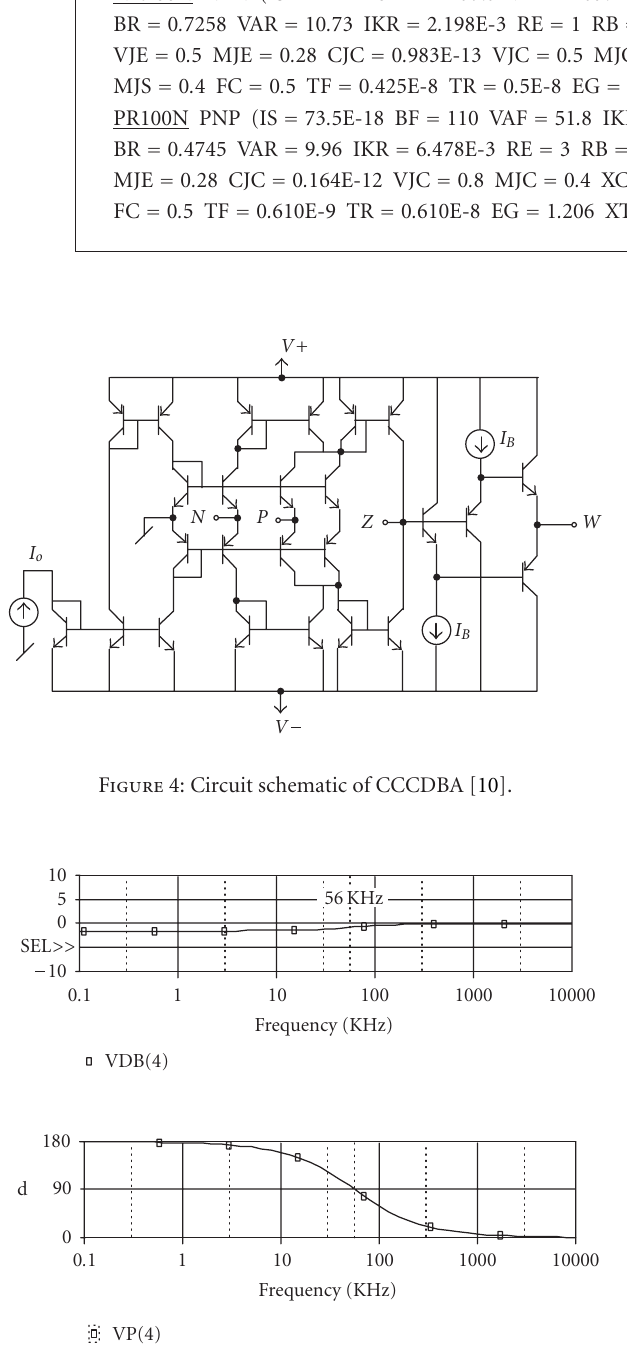
of 115KHz as shown in Figure 6, as against the designed value of 119KHz. Thus the proposed all-pass filter circuits are verified.